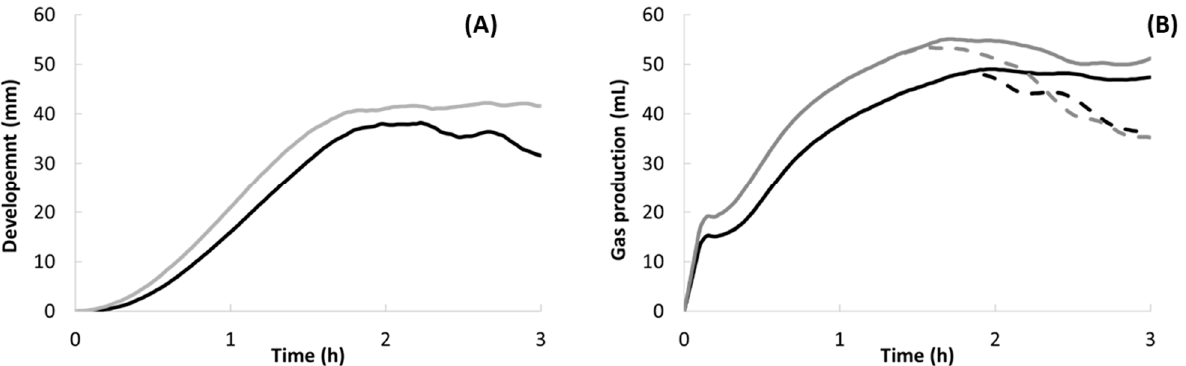
Figure 5. Dough development ( A ) and gas production ( B ) of doughs prepared from wheat flour (black line) and rye-wheat blend (30:70) (grey line). In panel B, solid lines refer to produced gas, whereas dotted lines refer to retained gas in the dough.